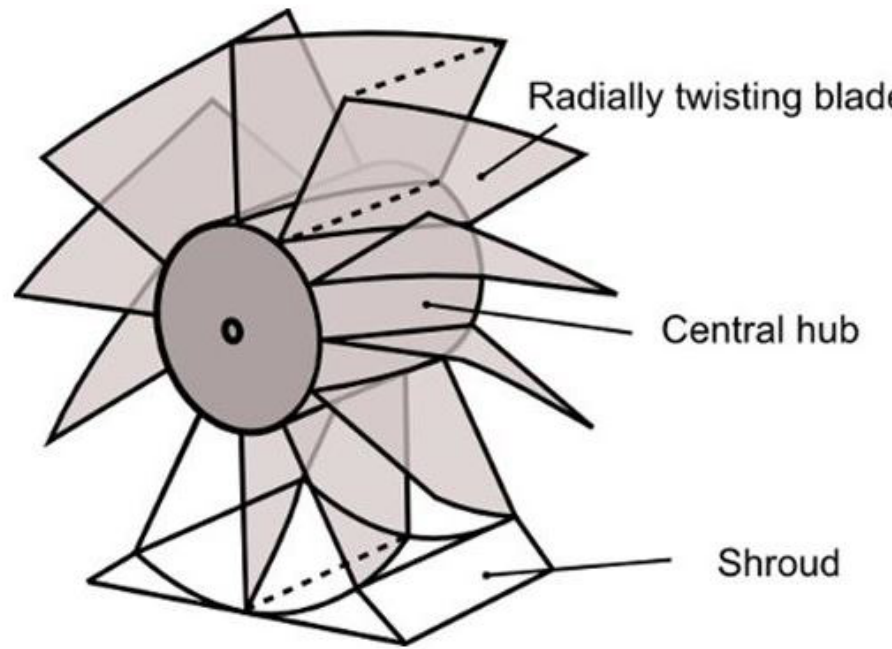
Figure 2. HPM with radially twisted blades and modified bottom shroud, taken from HYLOW Internal Task Report 2.3 [19]. In the present work, only the modification of the bottom shroud was